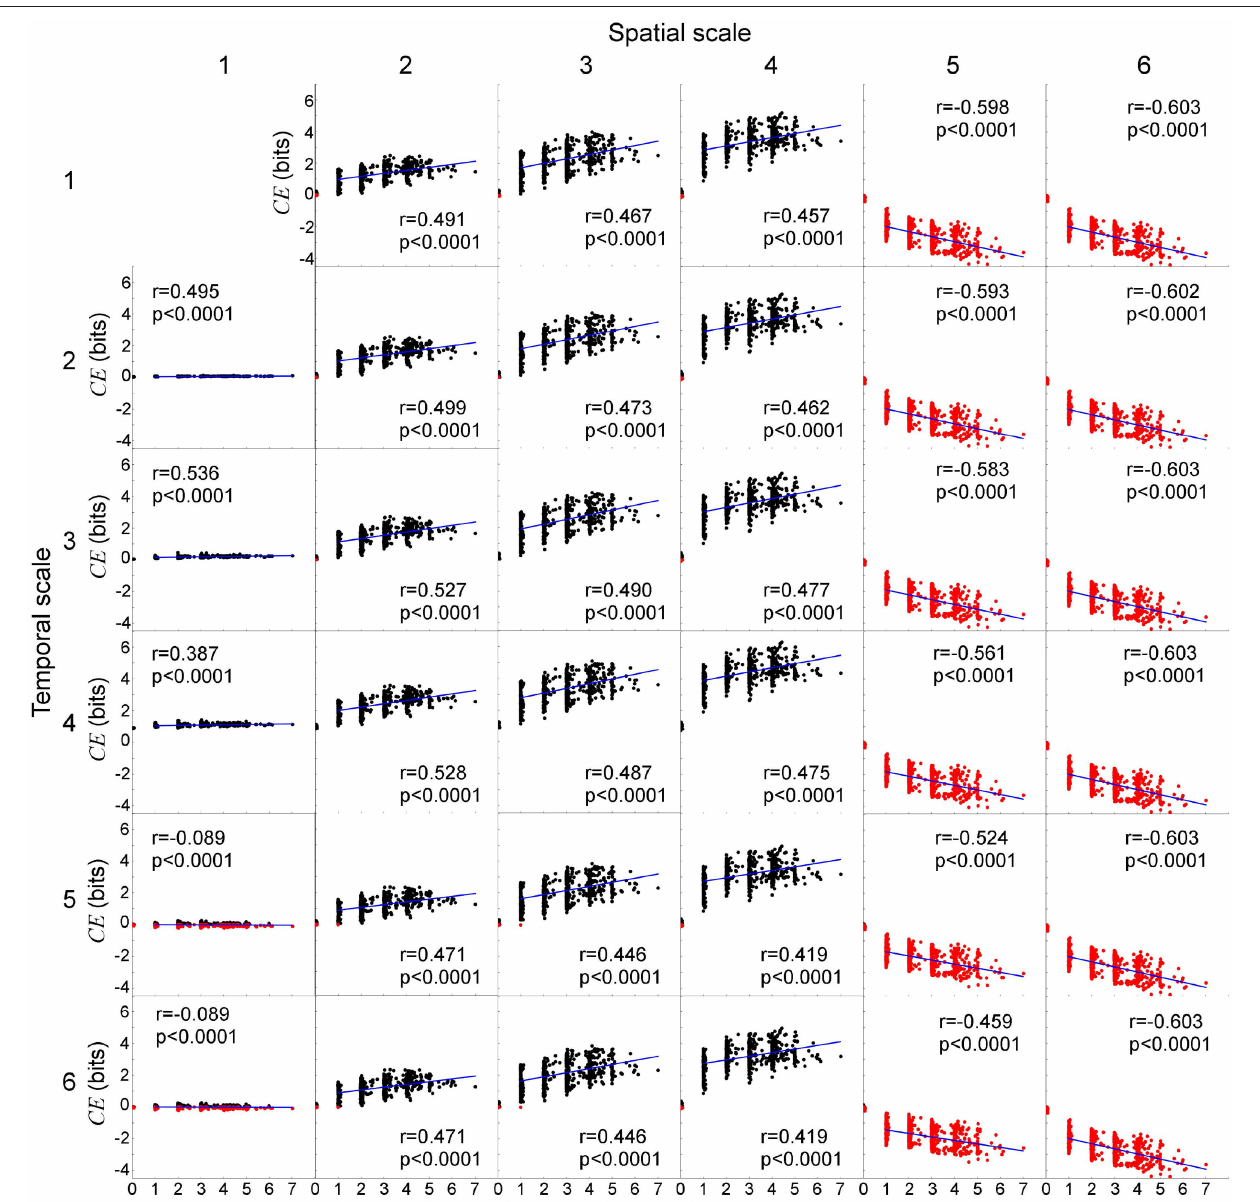
FIGURE 9 | Number of rotors and causal emergence. We quantify causal emergence ( CE ) with respect to the most microscopic system description at spatial scale = temporal scale = 1. Each subplot represents an association between the number of rotors and CE at each spatiotemporal scale. Black dots indicate CE > 0 (emergence), whereas red dots indicate CE < 0 (reduction). Blue lines indicate linear fit for the number of rotors ≥ 1. The columns represent the spatial scales (1 through 6) and the rows represent the temporal scales (1 through